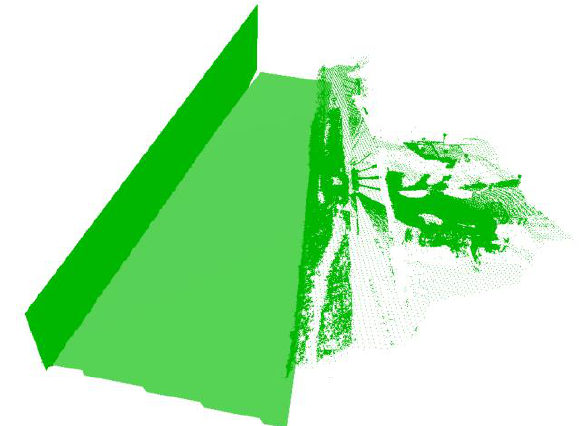
Figure 4. Vertical planes simulating the river-bed and southern bank, whereas the northern bank was modelled with the point cloud from TLS.